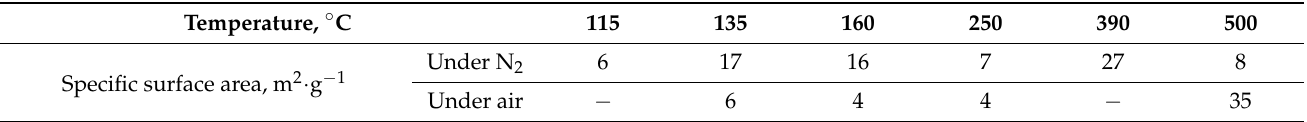
Figure 14. Photocatalysis of decomposition intermediates and products forming from compound 1 at various temperatures under nitrogen ( a ) and air ( b ) during the photodecomposition of Congo red. Figure 14 shows that among the two studied dyes, Methyl orange and Congo red; only the